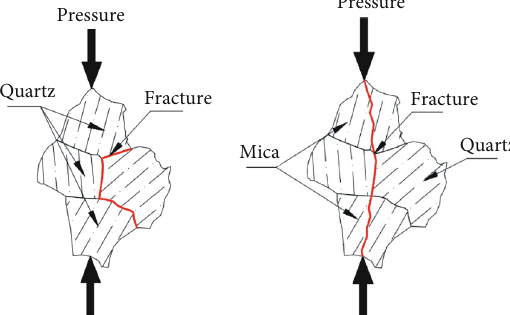
Figure 2: Development of granite fractures under di ff erent fabric conditions